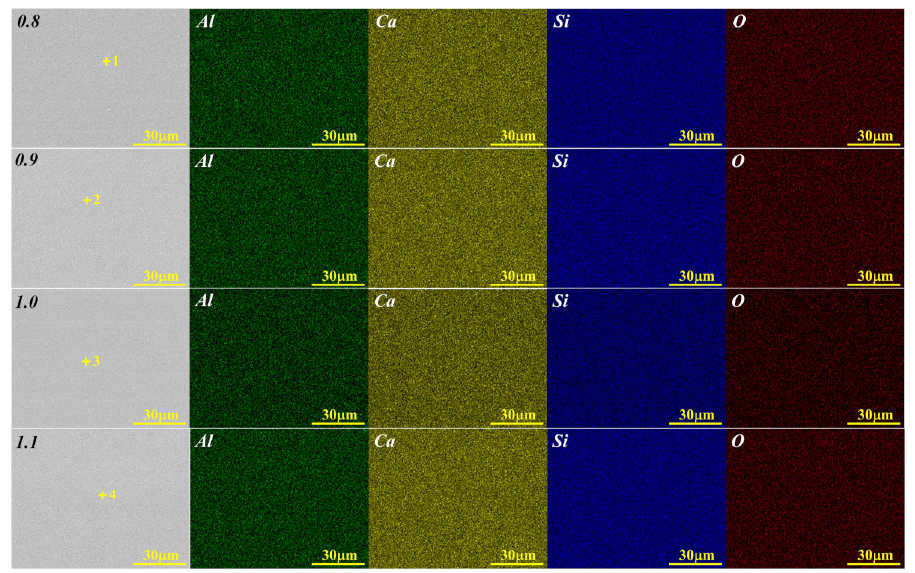
Figure 5. SEM and surface-scan photos of glass phases with a different R. Table 3. The EDS results of the corresponding marked points in Figure 5. Elements(At Pct) Marked Points R Ca Si Al P